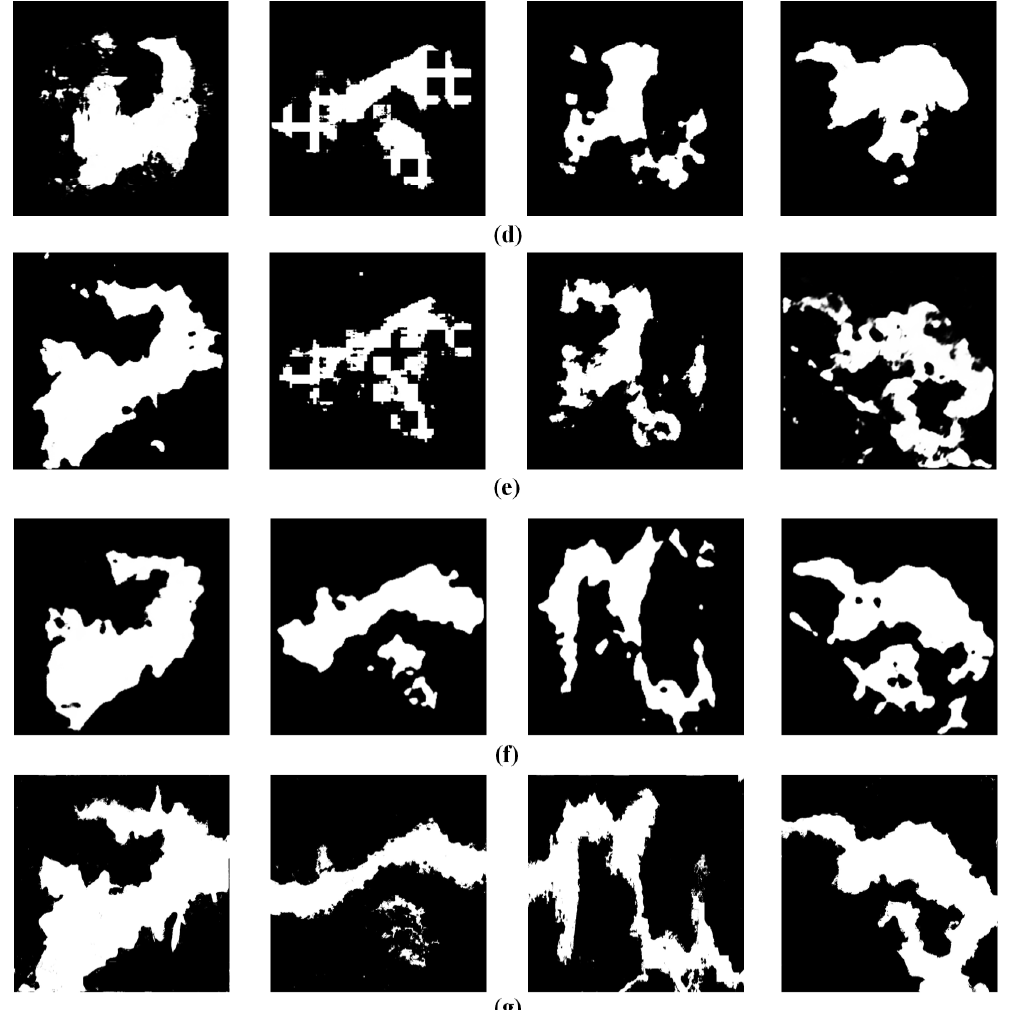
Figure 10. Examples of landslide extraction using test dataset. ( a ) is the RGB patches for visualization analysis, and ( b ) is the ground-truth landslides corresponding to ( a ). ( c – g ) are the experimental results obtained using U-Net, PSPNet, DeepLabv3+, pix2pix, and the proposed network, respectively.